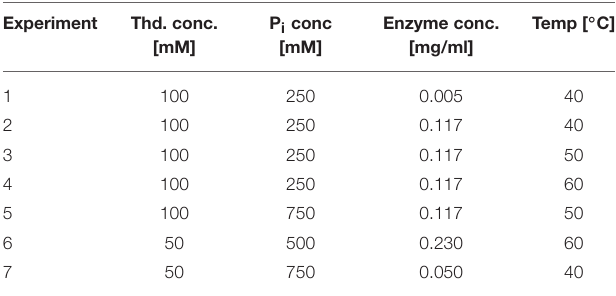
TABLE 3 | Experimental design.